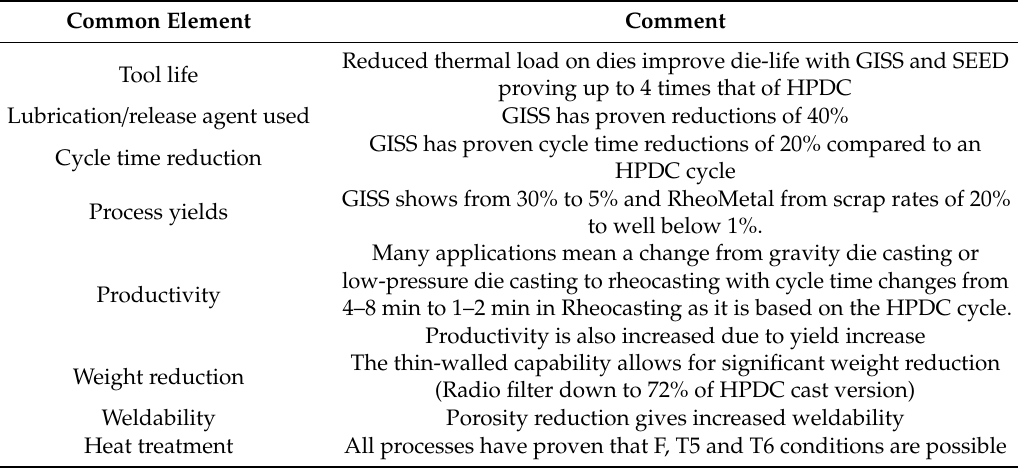
Table 1. Collation of common traits [21–25].